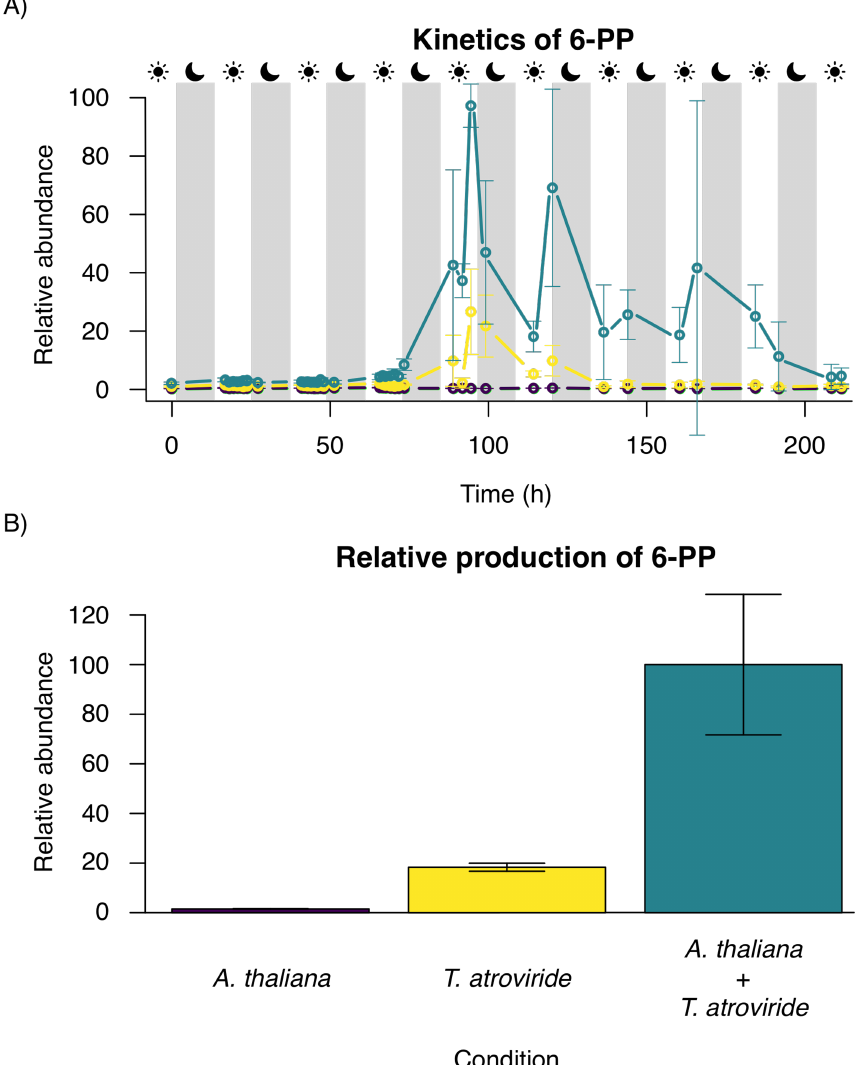
Figure 4. Monitoring of 6-PP production with low-temperature plasma (LTP) ionization mass spectrometry (MS). The mean value and the standard deviation for each measurement are shown. ( A ) The observed 6-PP concentration at night is higher, suggesting a circadian regulation. ( B ) The plant-fungal interaction between Arabidopsis thaliana and Trichoderma atroviride shows much higher levels of 6-PP than the individual pure cultures. The relative 6-PP production corresponds to the sum of all